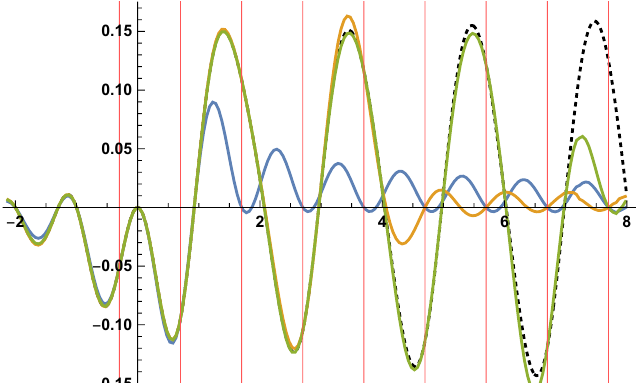
Figure 2 . Convergence of the s -channel block decomposition for the transform of z p (1 − z ) − q with p = 0 . 2 and q = 0 . 3 . The dotted line corresponds to I ( C ) p,q ( α ) . The blue, orange and green lines are obtained by keeping respectively 2, 5 and 8 terms in the sum on the right-hand side of equation (4.13). Notice that they respectively agree with the exact result for 2, 5 and 8 non-negative integer values of α − p +1 / 2 which are indicated by the red vertical lines. (For clarity of presentation we have divided all functions by 4 − α Γ( ± α ) which in particular removed all the poles at positive integer α .)